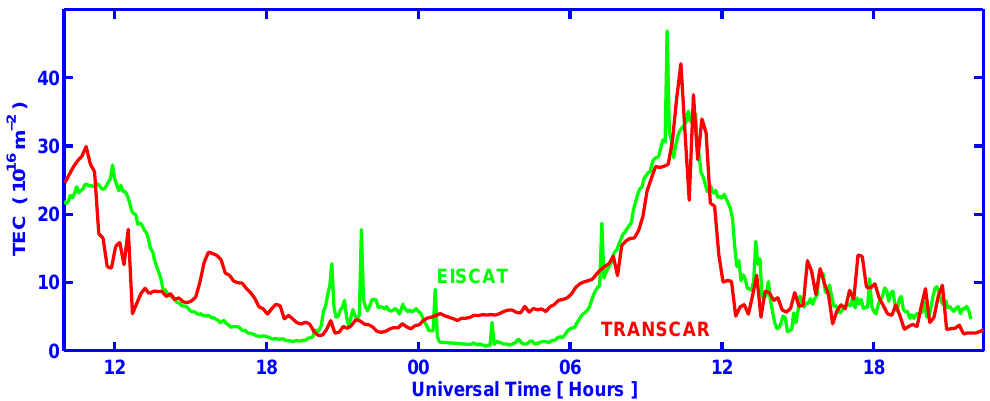
Fig. 10. Temporal evolution of the total electron content observed by EISCAT (green line) and calculated by TRANSCAR (red line), for the same period as Fig.